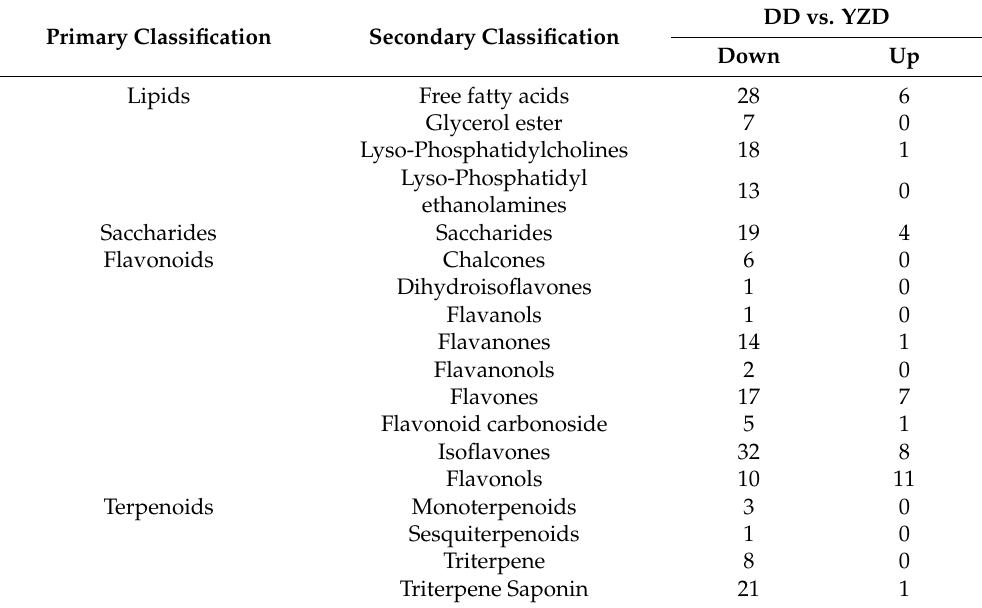
Table 2. Overview of the differentially accumulated metabolites in potential anti-diabetic components between YZD and